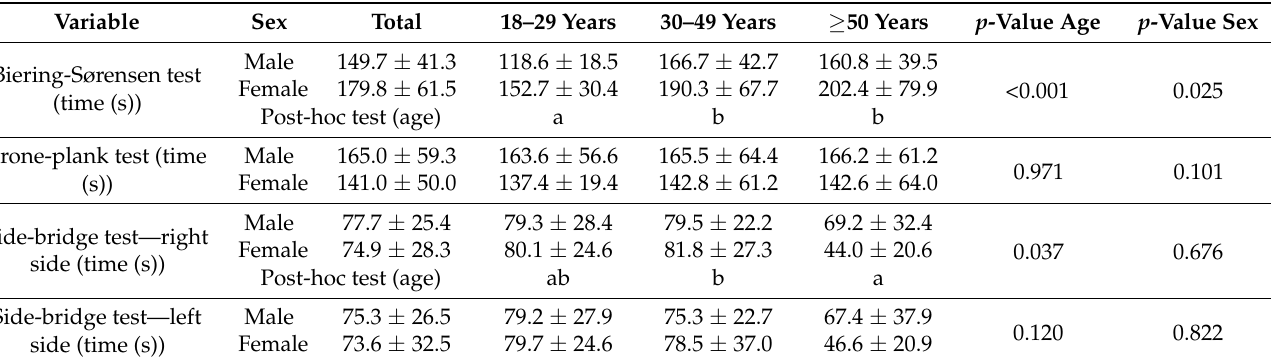
Table 6. Trunk muscular endurance tests: results.